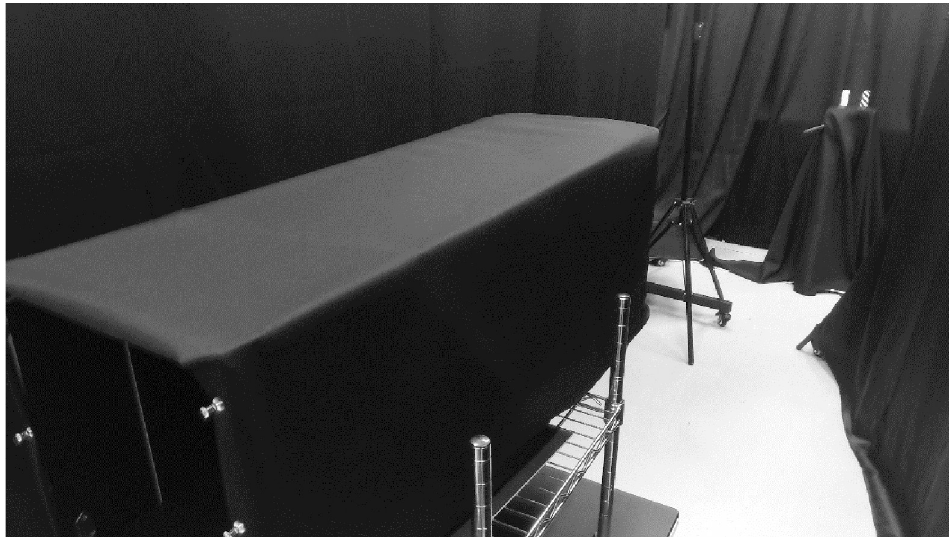
Fig 3. Experimental scene. The sunset environment was recreated by covering the participants’ surroundings with a blackout curtain. (This photo was taken in a bright room).